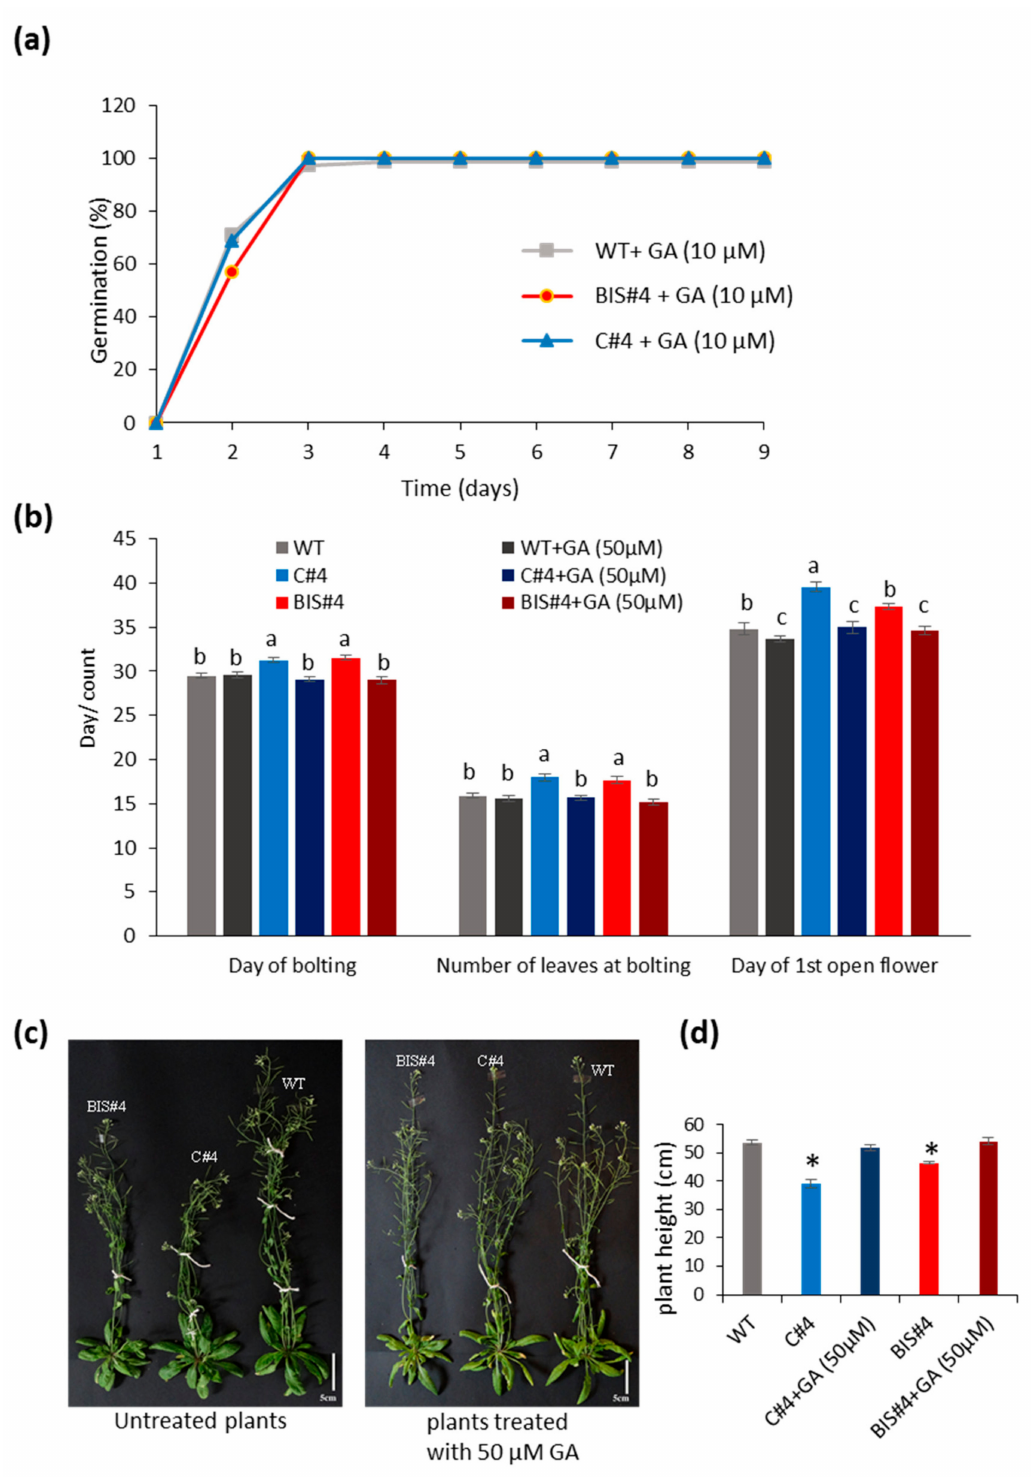
Figure 5. The e ff ect of exogenous application of GA 3 on AtCuAO δ mutant lines (C#4 and BIS#4) and wild type plants: ( a ) % germination on water agar medium containing 10 µ M GA 3 ; ( b ) day of bolting, number of leaves at bolting, and day of 1st flower opening with and without application of 50 µ M GA3 (n = 12); ( c , d ) stalk length with and without application of 50 µ M GA 3 ; scale bars = 5 cm. Error bars represent the standard error of the mean. Letters indicate a statistically significant di ff erence between treatments within each character measured using one-way ANOVA ( p ≤ 0.05). Asterisks indicate a significant di ff erence from WT at p ≤ 0.05 based on a Student t -test. The experiment was repeated twice with similar